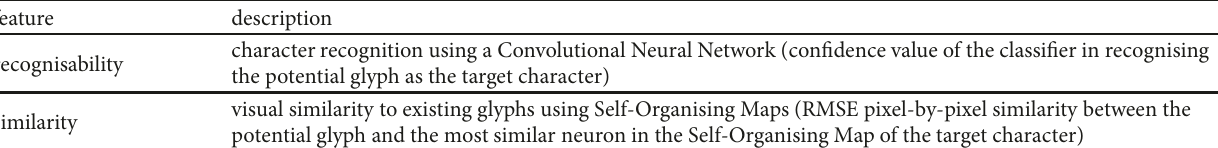
Table 1: Behaviour